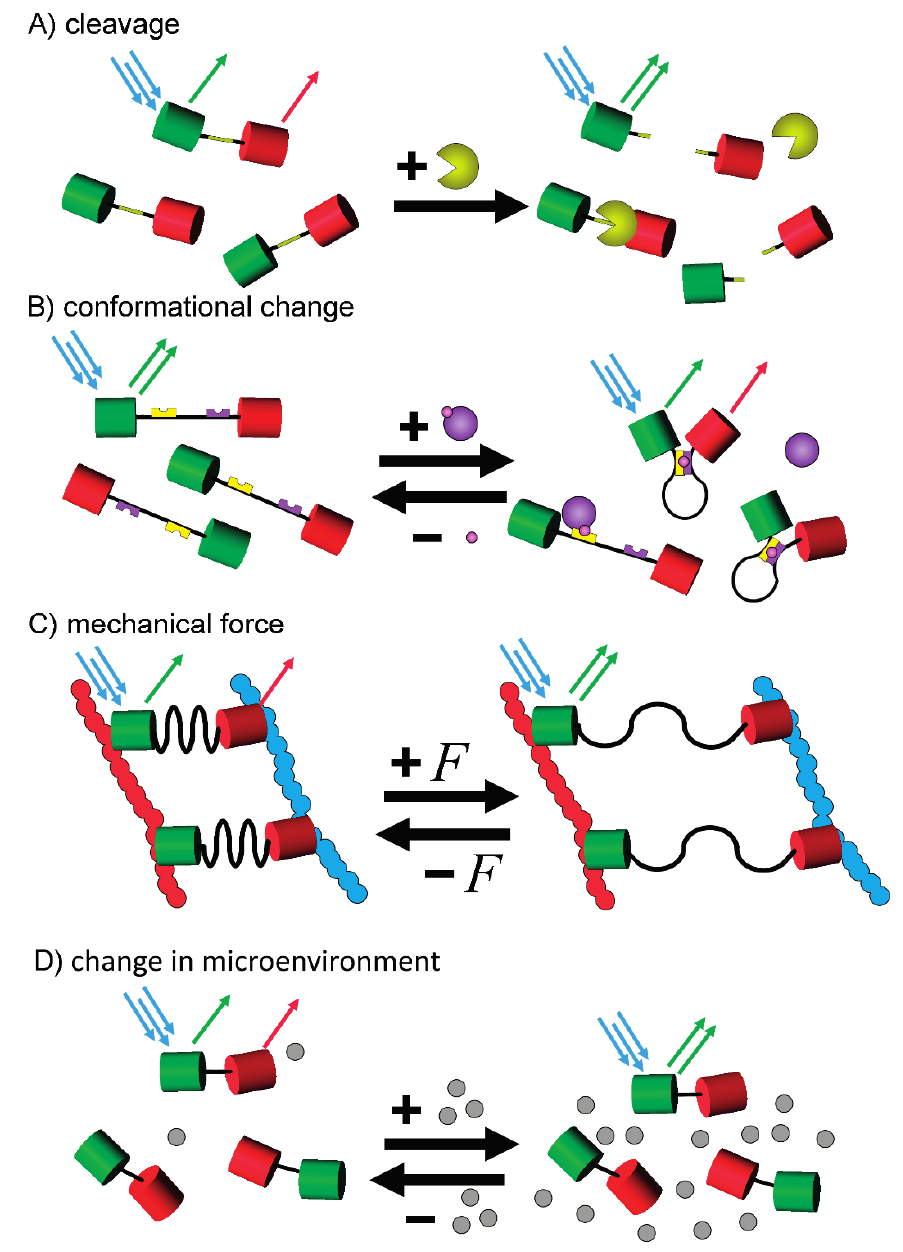
Figure 5. The different types of fluorescent-protein based FRET-biosensors. FRET biosensors indicate a biological change through a change in the FRET signal caused by an alteration of the donor-acceptor distance by ( A ) cleavage of a linker domain; ( B ) a conformational change due to internal alterations or ( C ) a conformational change due to the effect of an external mechanical force. Furthermore, the FRET signal might also be altered ( D ) by a change of the fluorescence properties triggered by a change of the surrounding environment of the fluorophores. The given schemes are only basic examples and many biosensors include alterations to these basic principles, e.g., for conformational change based sensors, the process can be inverted with a high FRET signal at resting state, and the decrease of said signal after posttranslational modification, or the fluorophore pair of a biosensor could be integrated between sensor domains in the middle of a